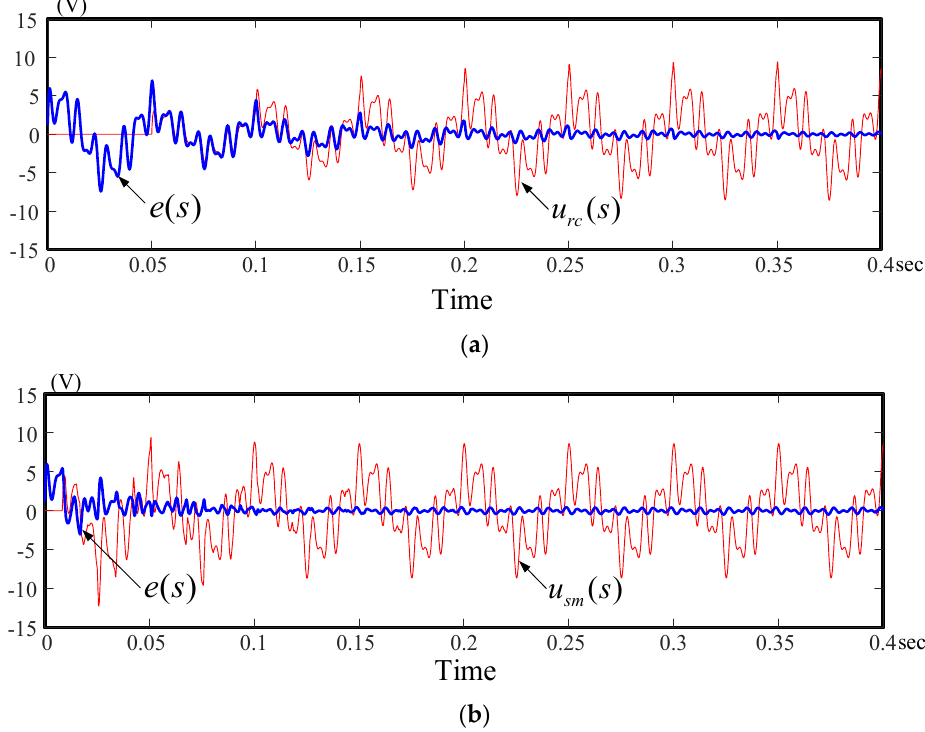
Figure 9. Responses between different controllers of current-loop control: ( a ) CPC; ( b ) SHC.